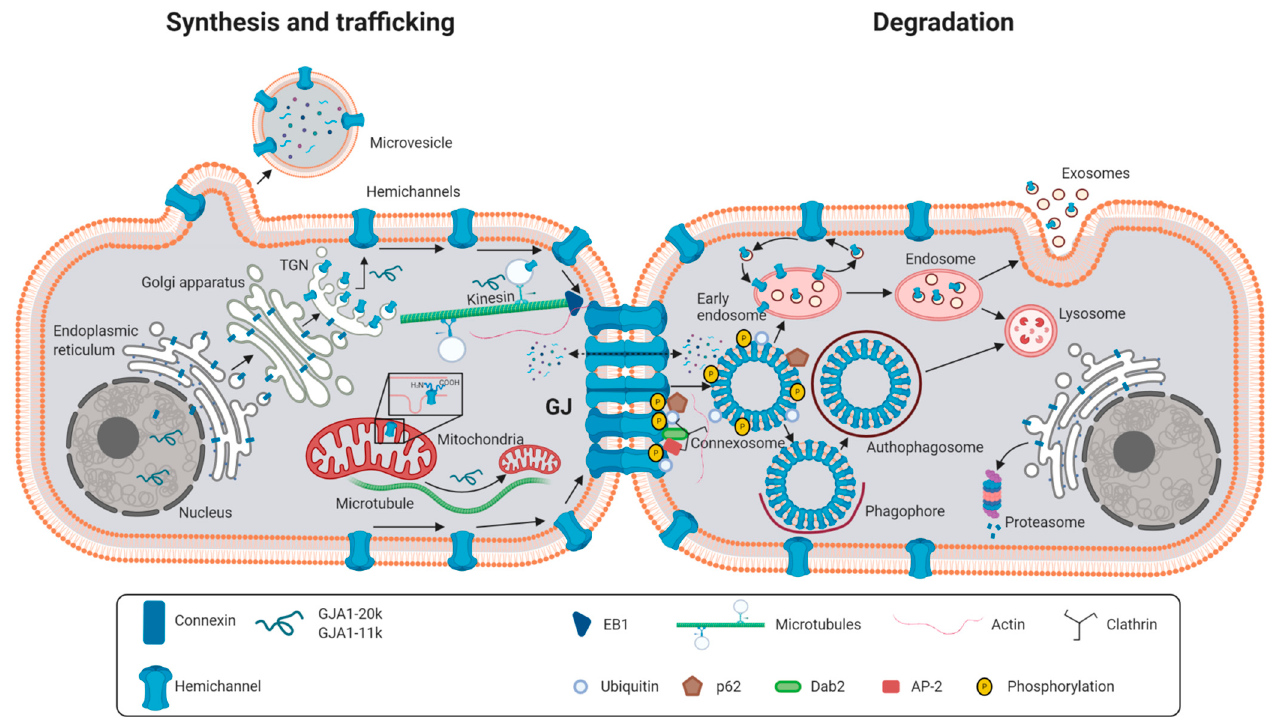
Figure 3. Synthesis and intracellular trafficking (left cell) and degradation (right cell) of connexins. Connexins are synthesized at the endoplasmic reticulum but are oligomerized into hemichannels at the cis-Golgi apparatus or at the trans-Golgi network (TGN). Transport to the plasma membrane occurs predominantly through microtubules and motor proteins such as kinesin, but actin may also play an important role. Direct delivery of vesicles containing hemichannels may also occur. Cx43 reaches mitochondria using the TOM/TIM system of protein import, in an Hsp90-dependent manner. N-terminally truncated isoforms can be found at the cytoplasm and nucleus. Degradation occurs through formation a double-membrane structure, termed connexosome. Connexosomes can then be targeted to the endolysosomal or the autophagosomal pathways. Connexins can also be degraded after synthesis at the endoplasmic reticulum by the proteasome. Release of microvesicles and exosomes containing connexins is also depicted. GJ indicates gap junctions. Created with Biorender.com (accessed on 15 April 2021). Modified from [8,12,27].